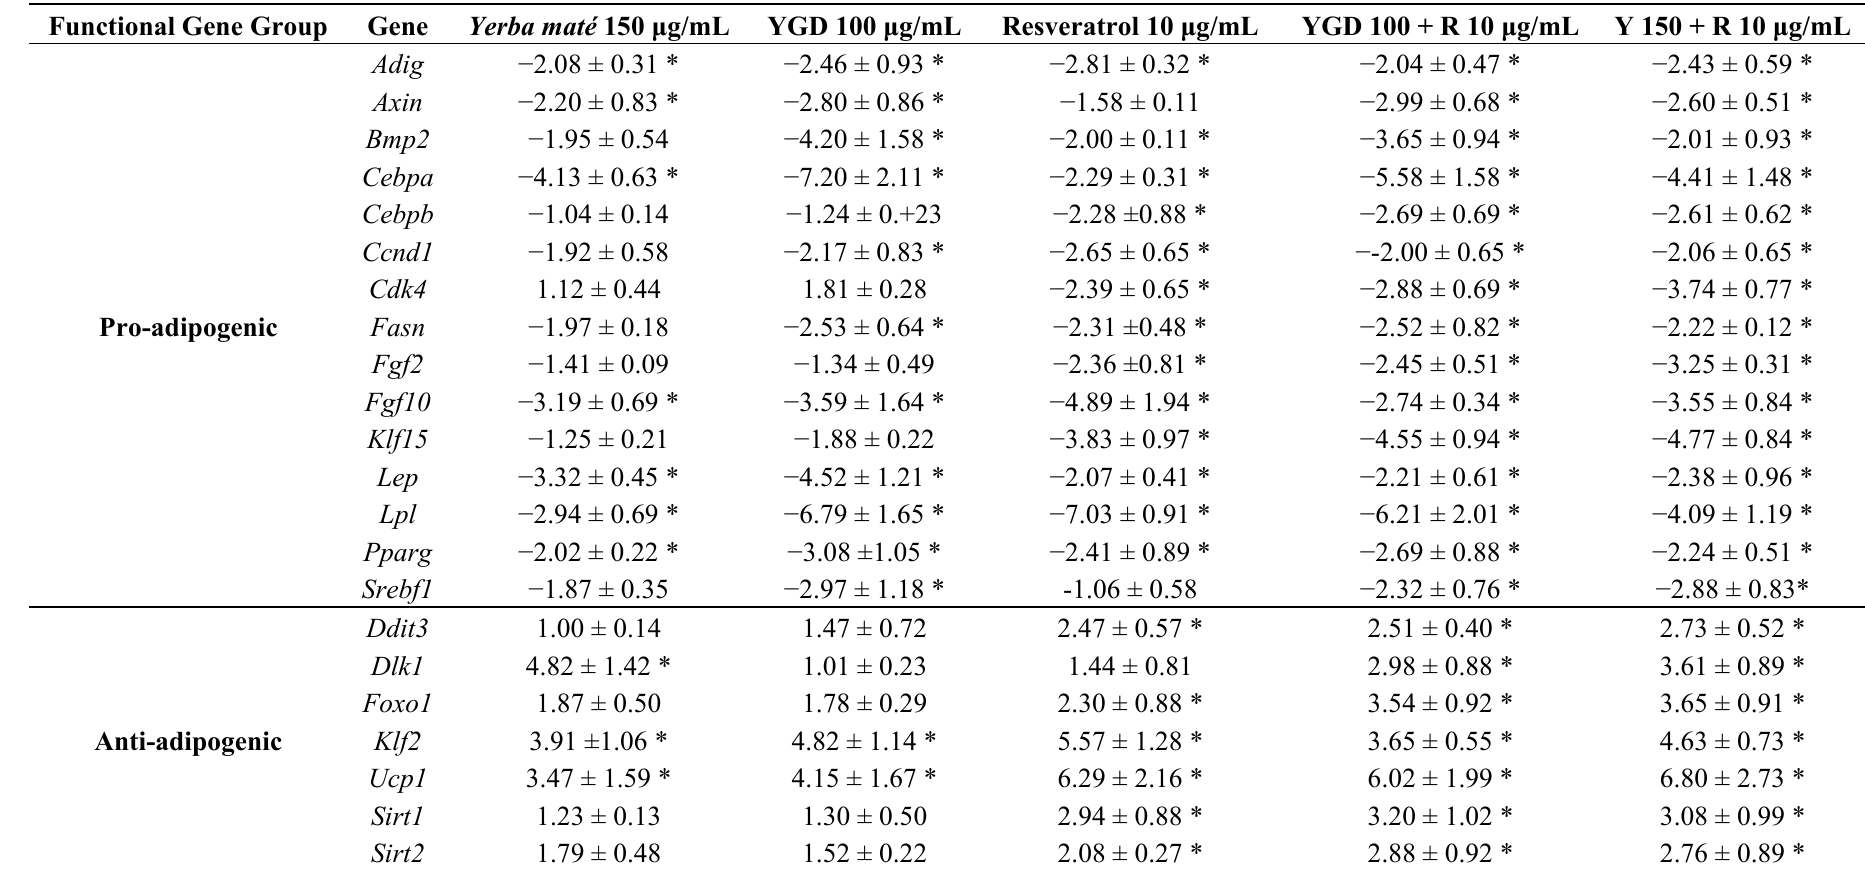
Table 1. Fold regulation results from the PCR